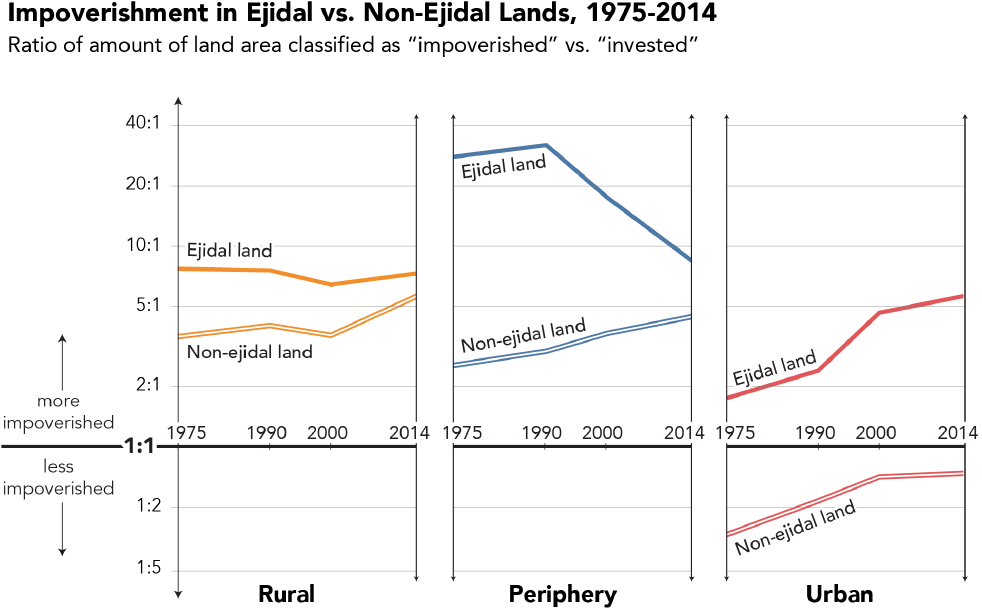
Figure 8. Ejidos and ratio of invested/divested GSV landscapes.